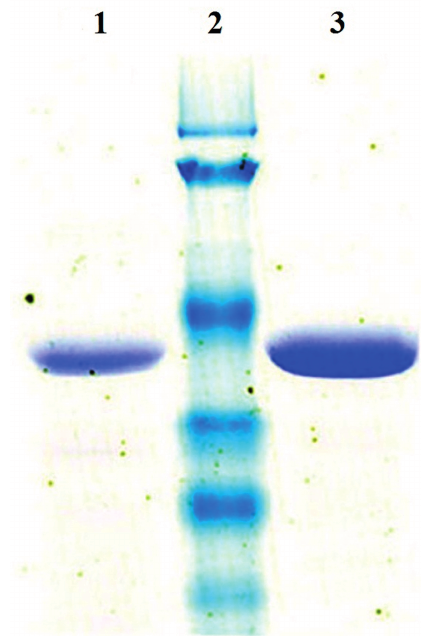
Figure 1. SDS-PAGE analysis of the purified ReBDH with or without N-terminal His-tag. Lane 1, the purified ReBDH without N-terminal His-tag; lane 2, molecular weight marker (from top to bottom: 120, 85, 50, 35, 25, and 20 kDa); lane 3, the purified ReBDH with N-terminal